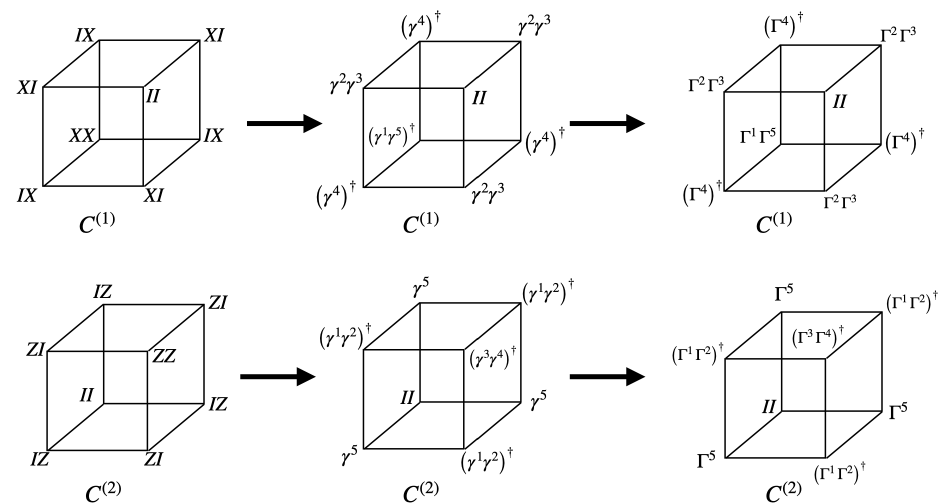
Figure 1: Cube operators of the Haah code. The notation indicates the product of Pauli operators in each site, e.g., ZZ ≡ σ Z ⊗ σ Z . The γ I are the associated Dirac operators. The Γ ( I , α ) of each cube are equivalent to γ I but needed for a consistent effective theory. The α index is supressed in the figure for